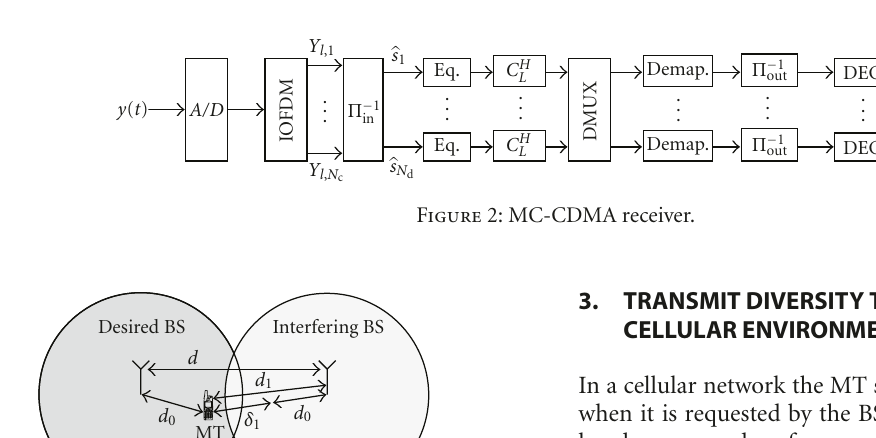
Figure 1: MC-CDMA transmitter of the n th base station.